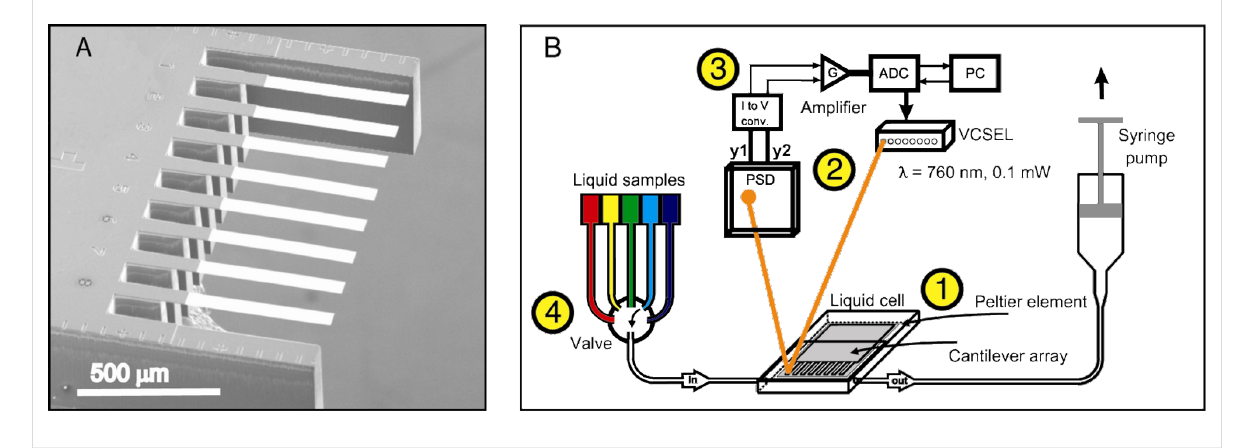
Figure 1: (A) Scanning electron microscope image of a silicon microcantilever array consisting of eight cantilevers and two sidebars. (B) Schematic drawing of the sensor instrument: 1 - the measurement cell with a mounted microcantilever array, 2 – optical-read out system comprising vertical cavity surface emitting lasers (VCSELs) and a position sensitive detector (PSD), 3 – data processing and acquisition, 4 – valve selector connected to liquid samples.